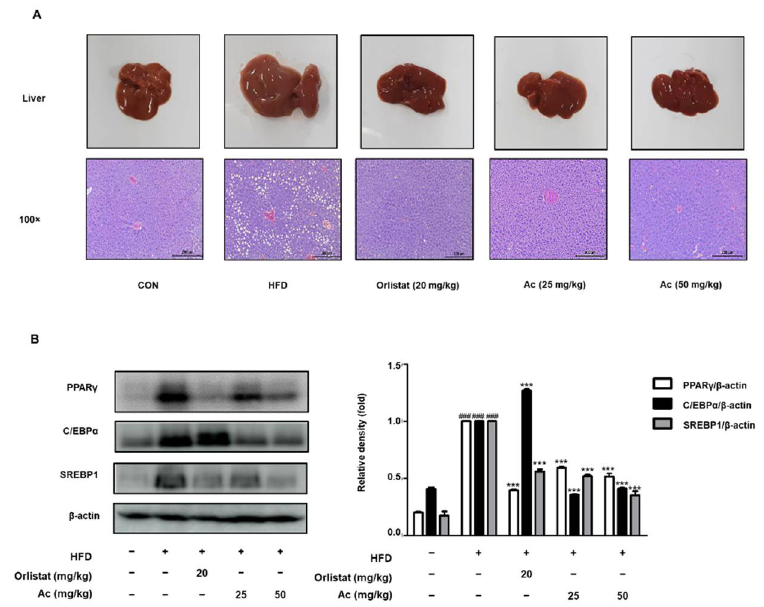
Figure 5. Effect of Ac on the adipogenesis in the liver tissue of HFD-induced obese mice. ( A ) Macroscopic analysis and representative images stained with H&E in liver tissue. Scale bar is 200 µm. ( B ) the protein level of PPARγ, C/EBPα, and SREBP1 in the liver analyzed by western blot analysis. Data are expressed as the mean ± SD of three independent experiments. ### p < 0.001 vs. chow diet-fed group; *** p < 0.001 vs. only HFD-fed group.